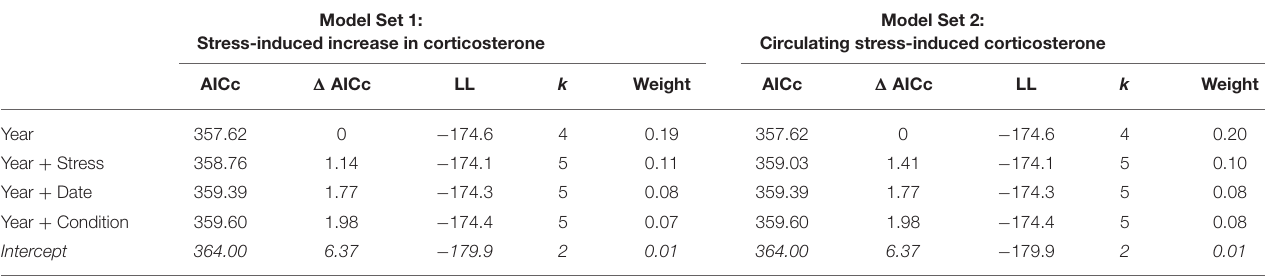
TABLE 3 | Model comparisons of the predictors of reproductive success in male tree swallows, showing all candidate models within 2 1 AICc of the best-fit model. Model Set 1: Stress-induced increase in corticosterone